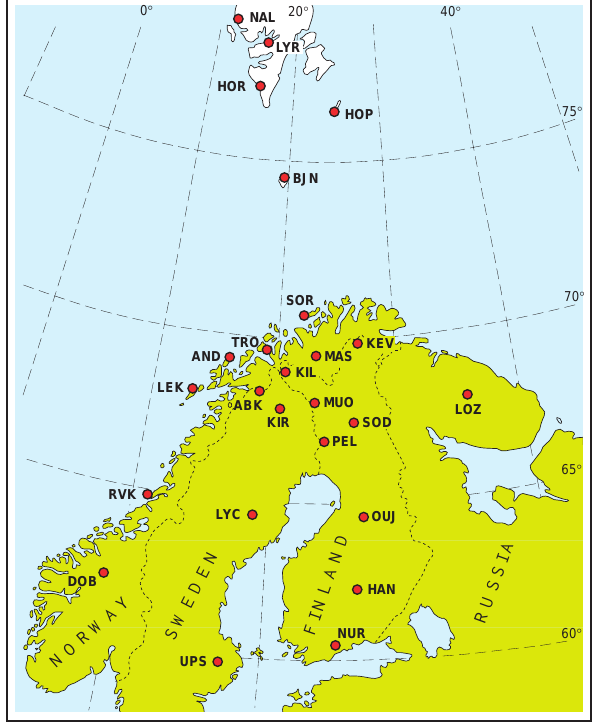
Fig. 1. IMAGE magnetometer stations in 2000. Geographic lati- tudes and longitudes are shown in the figure. Geomagnetic latitudes are approximately obtained by subtracting 3 ◦ from the geographic